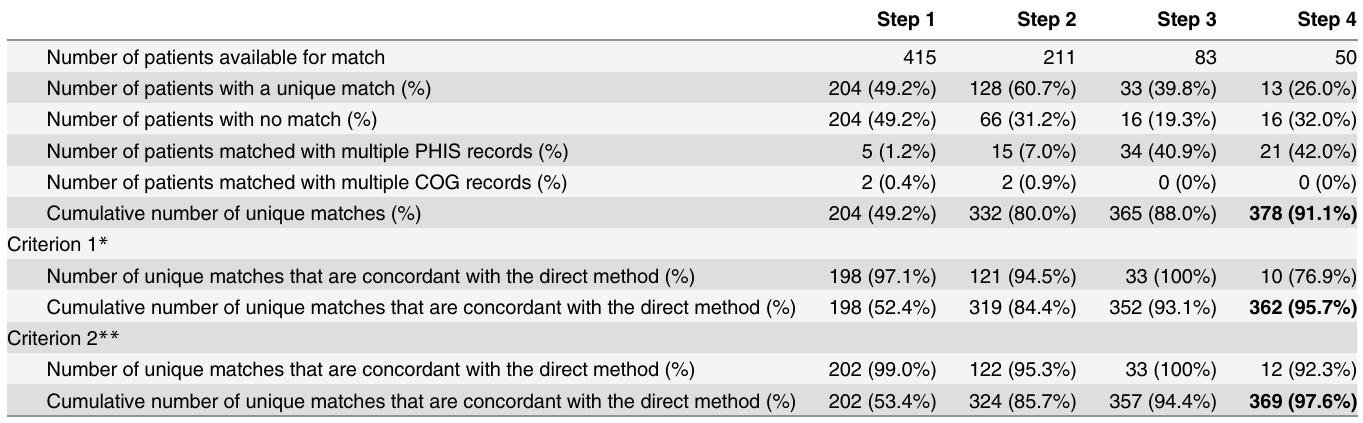
Table 3. Matching results using the indirect stepwise algorithm, developed on AAML0531. Note: The number of unique match from the direct merge method was 383